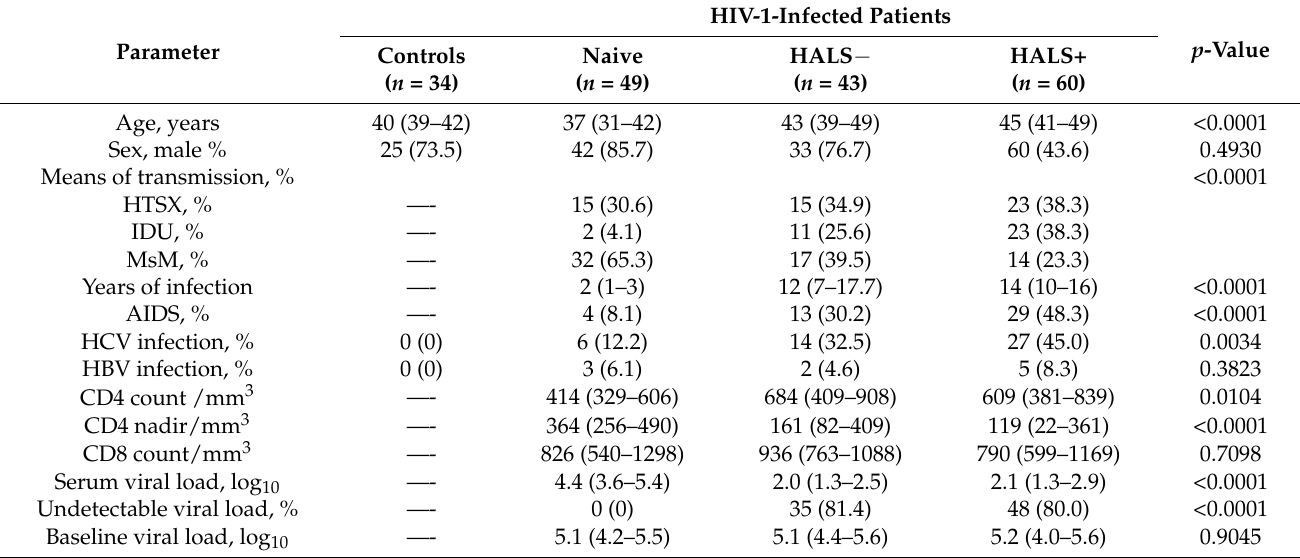
Table 1. Demographics, HIV-1 infection and antiretroviral exposure